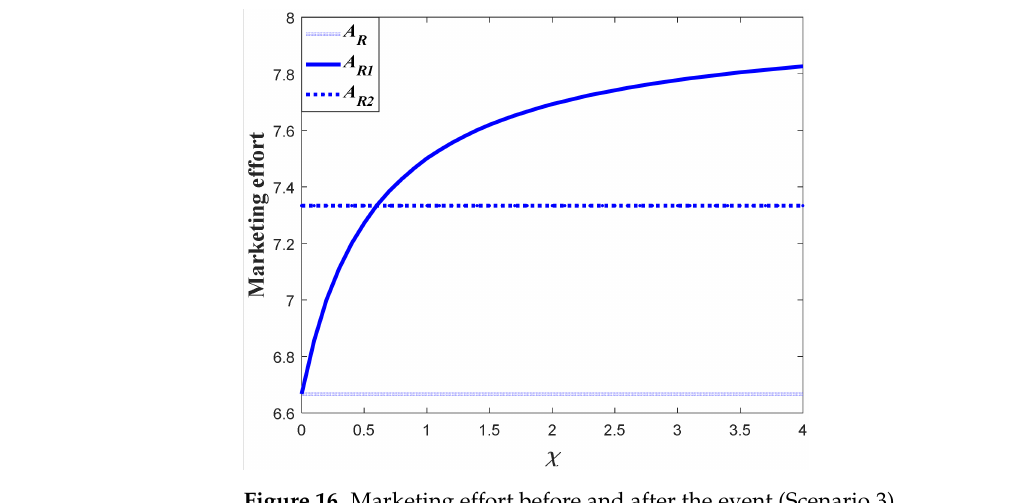
Figure 16. Marketing effort before and after the event (Scenario 3).